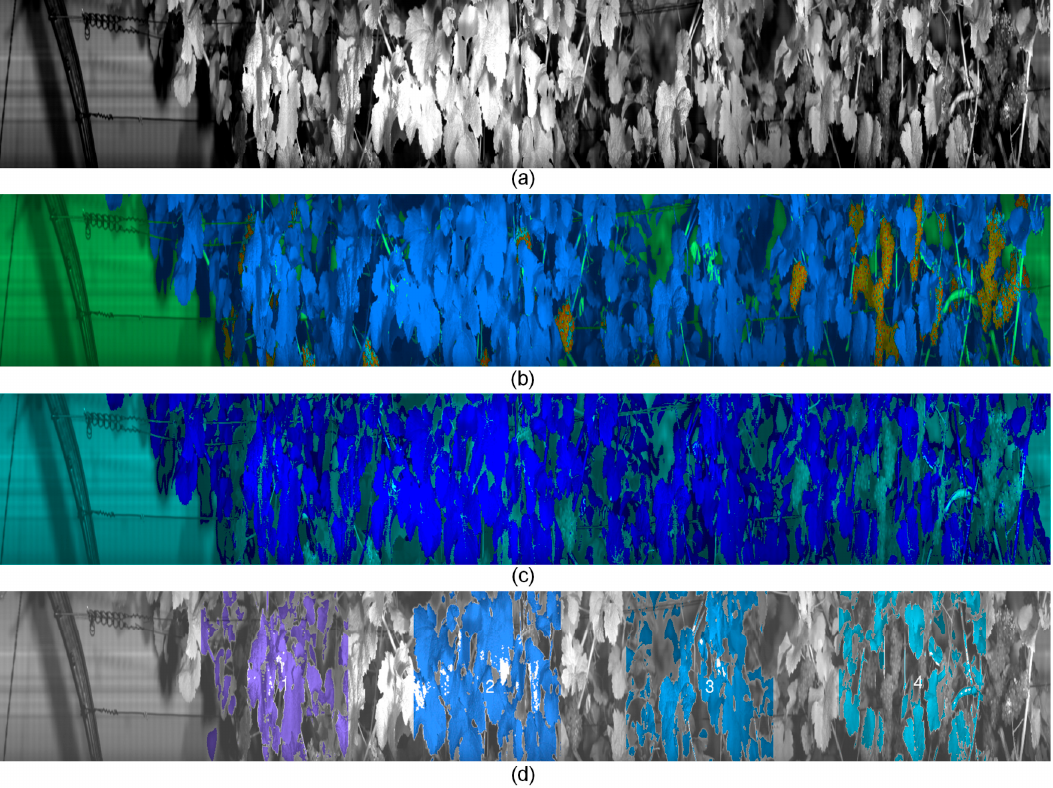
Figure 7. Pre-processing of hyperspectral image recording: ( a ) channel image at 1100nm, ( b ) clustering of spectral data, colour indicates pixel groups, ( c ) classification for foreground (leaves) vs. background, ( d ) image after removal of dark areas and marking of vine position from GPS.